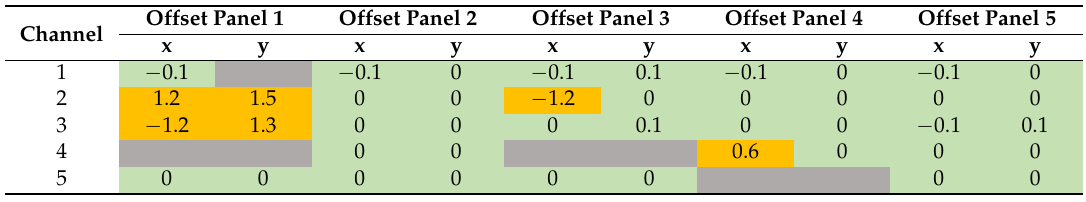
Table 2. Results of the first electrical test of the five test panels after assembly process and prior to encapsulation. Green stands for a calibrated signal and orange for a signal within the tolerance range. Gray marks the dysfunctional channels.